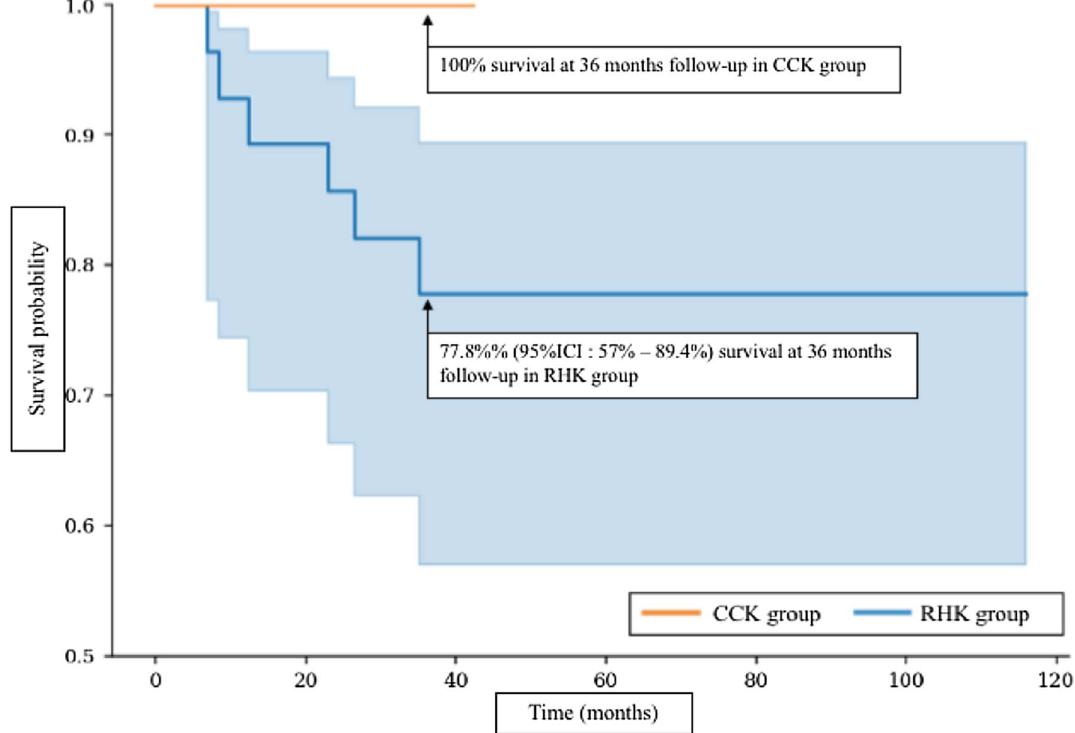
Figure 4. Re-revision-free survival curves comparing the CCK group and RHK